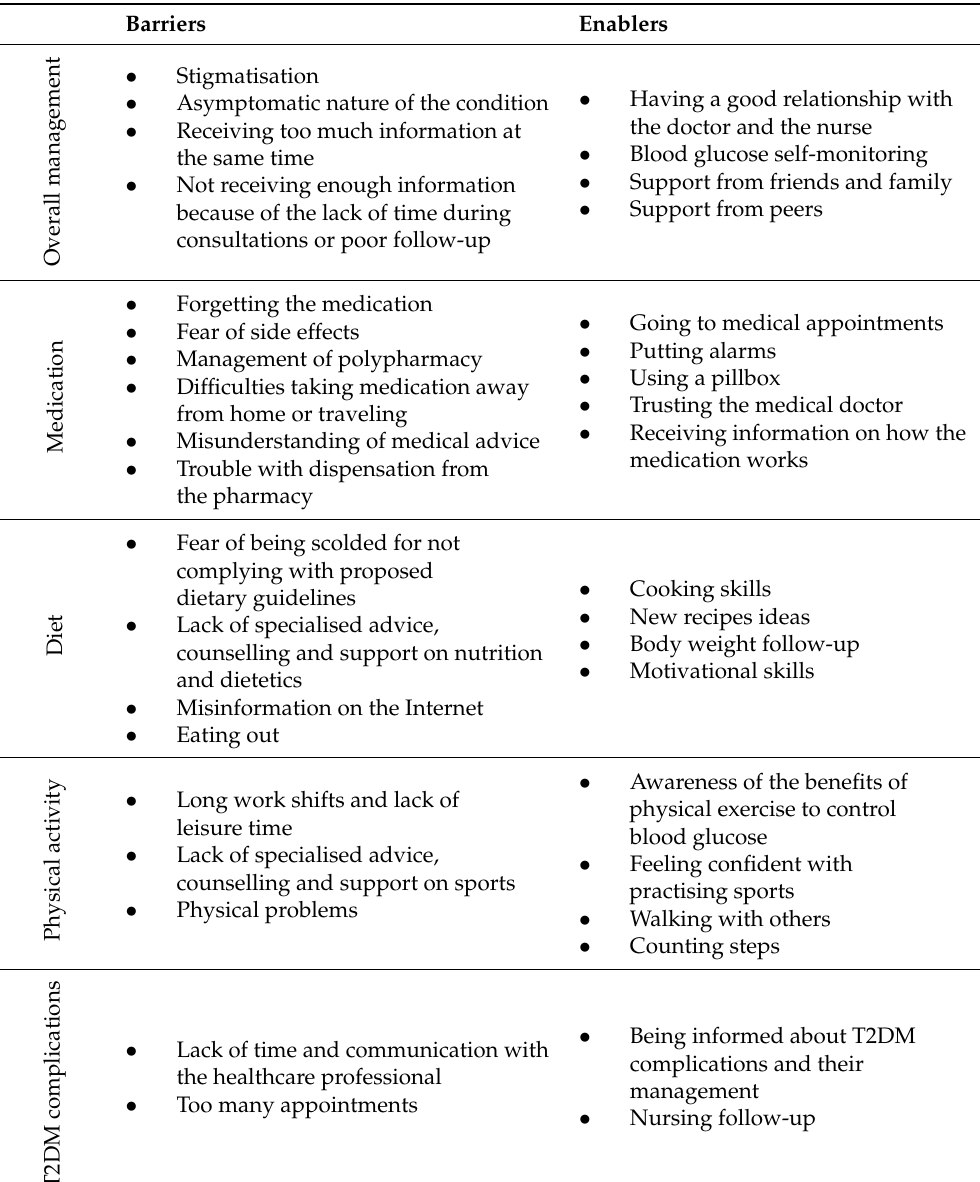
Table 2. Barriers and enablers for DSM that were identified from four focus group discussions with people with type 2 diabetes in the Balearic Islands (Spain) during October 2019 and January